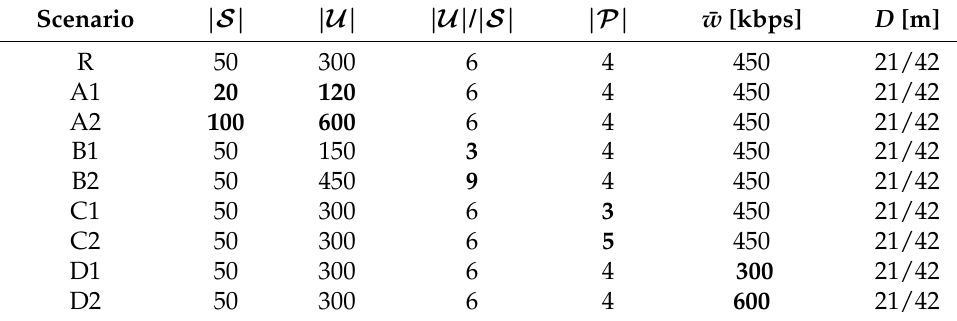
Table 1. Parameter values for the test